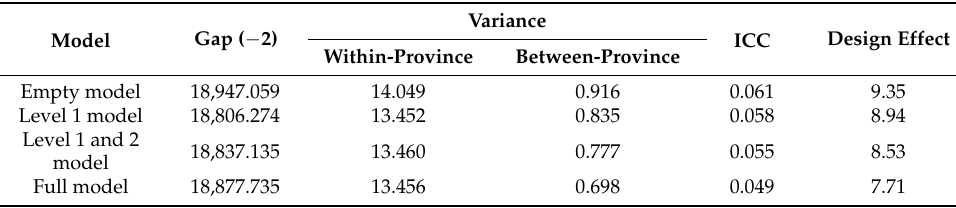
Table 6. The gap value, variance, ICC, and design effect value of